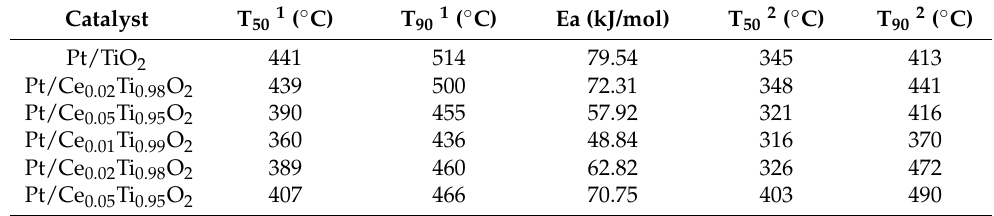
Table 1. Catalytic activity and Ea values of Pt/Ce x Ti 1 − x O 2 (x = 0, 0.002, 0.005, 0.01, 0.02, and 0.05)